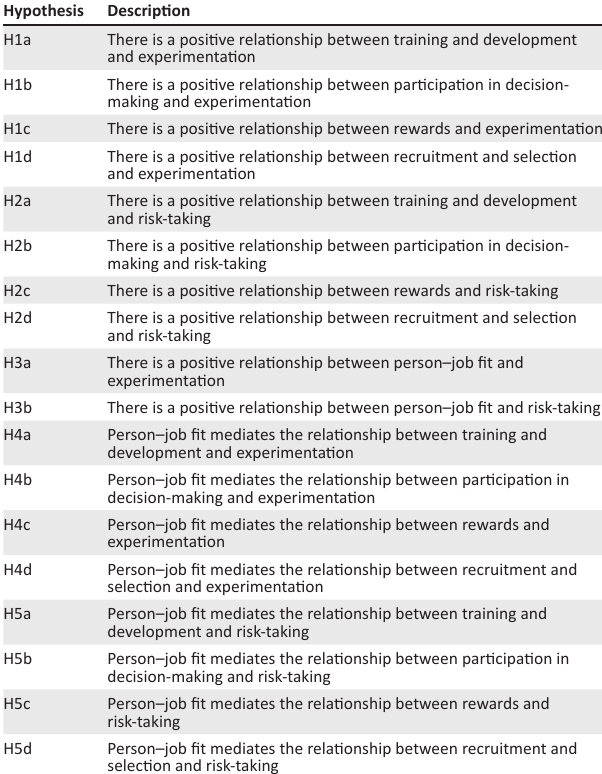
TABLE 1: Summary of the research hypothesis. Hypothesis